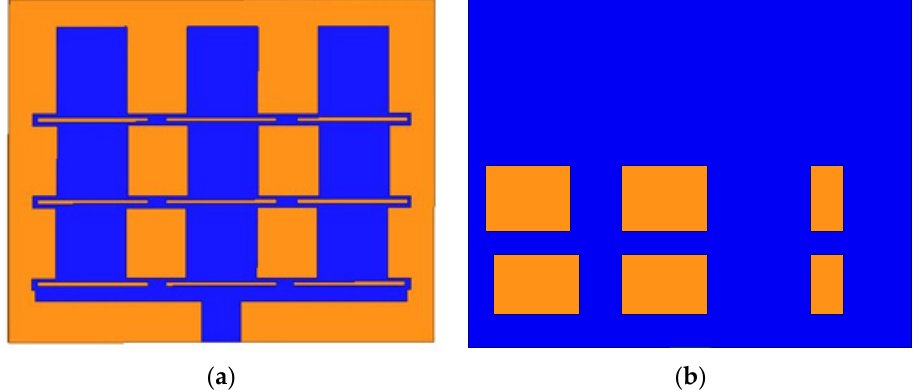
Figure 3. ( a ). Top view of the antenna (N) showing the patch array structure of the antenna, ( b ) bottom view of the antenna showing the ground plane with the first set of three cuts.